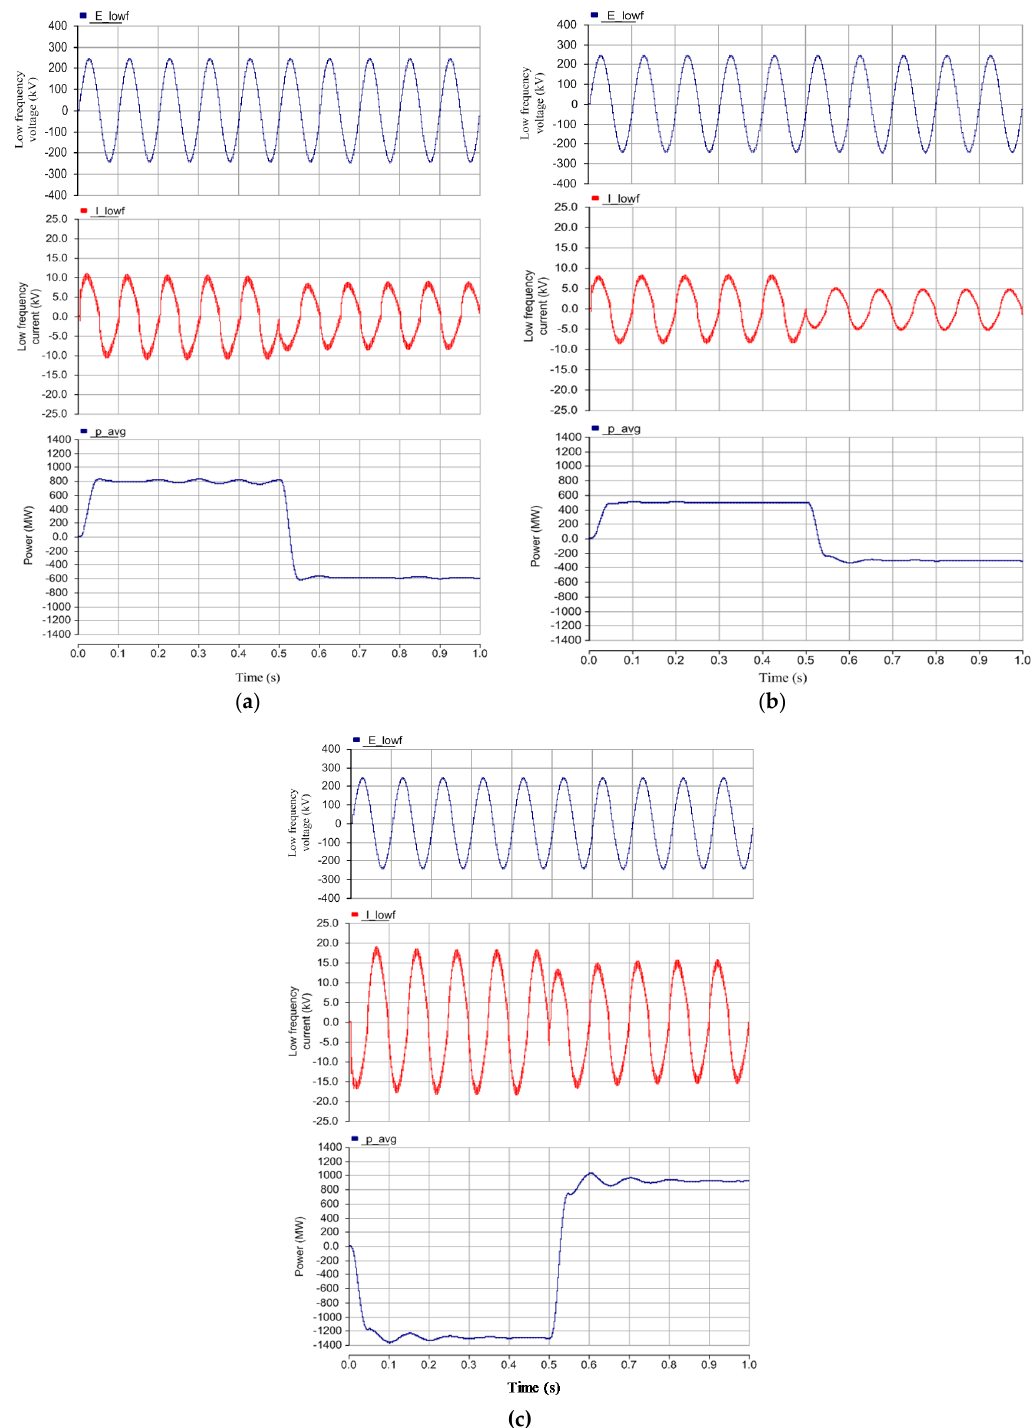
Figure 20. Low frequency side waveforms (voltage, current and power) on ( a ) terminal 1; ( b ) terminal 2; and ( c ) terminal 3.